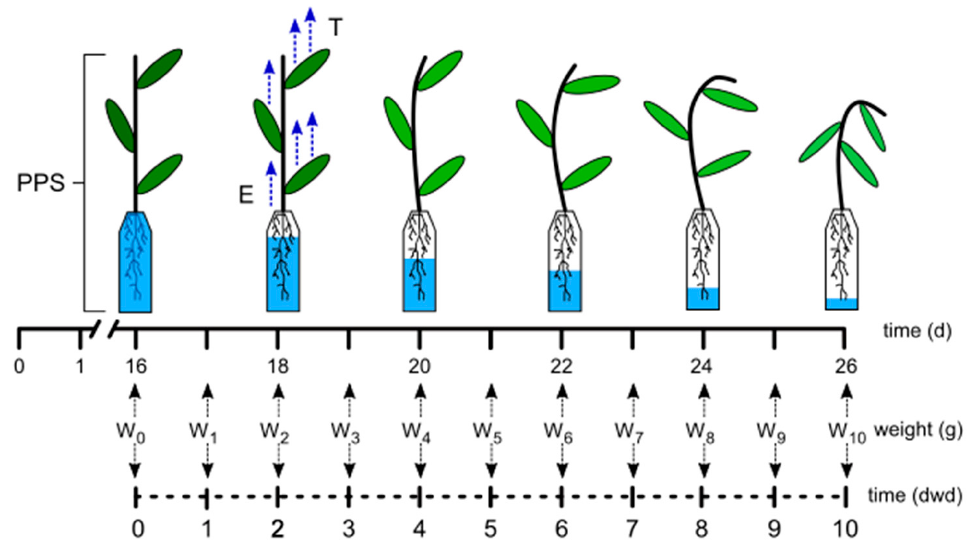
Figure 1. Schematic illustration of the experiment for determining water consumption. Plants were maintained at field-capacity condition until day 16, after which the water supply was suspended. The Plant Pot Substrate system (PPS) was weighted daily for 10 days ( t = 0 until t = 10). Evaporation: E ; transpiration: T ; days of water deficit: dwd.